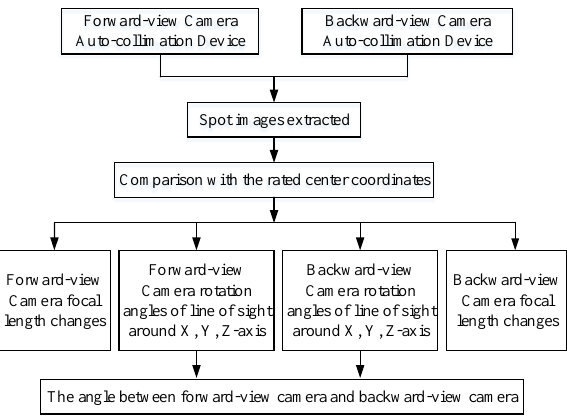
Figure 4. Data processing flow chart